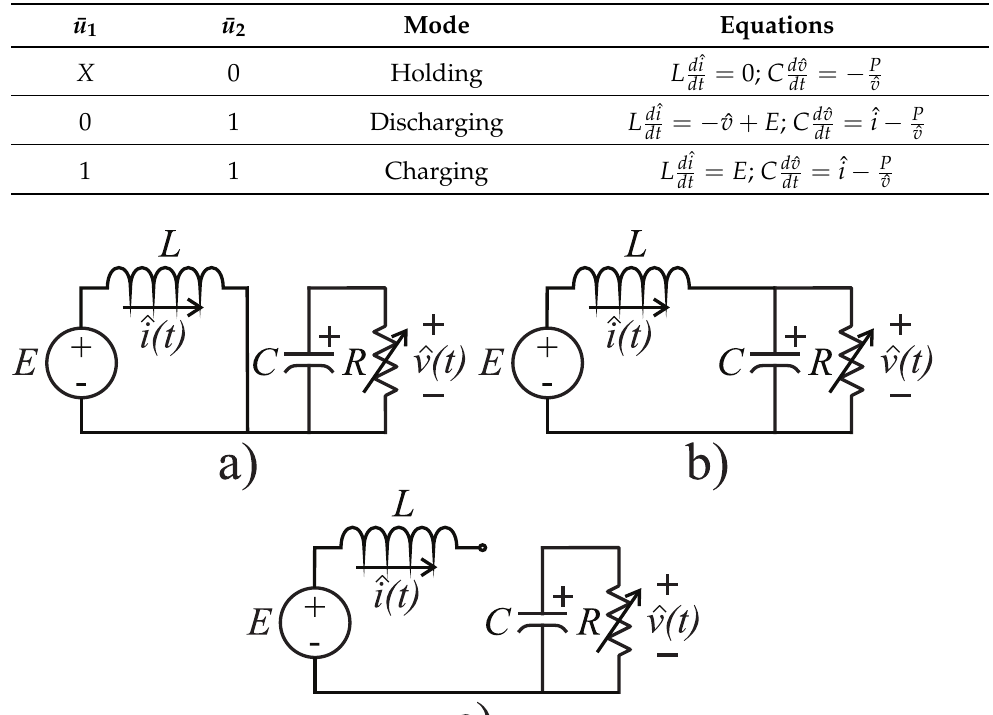
Figure 3. Idealization of the Boost converter operating in DCM through two ideal switches. Table 2. Current flow modes of the inductor.